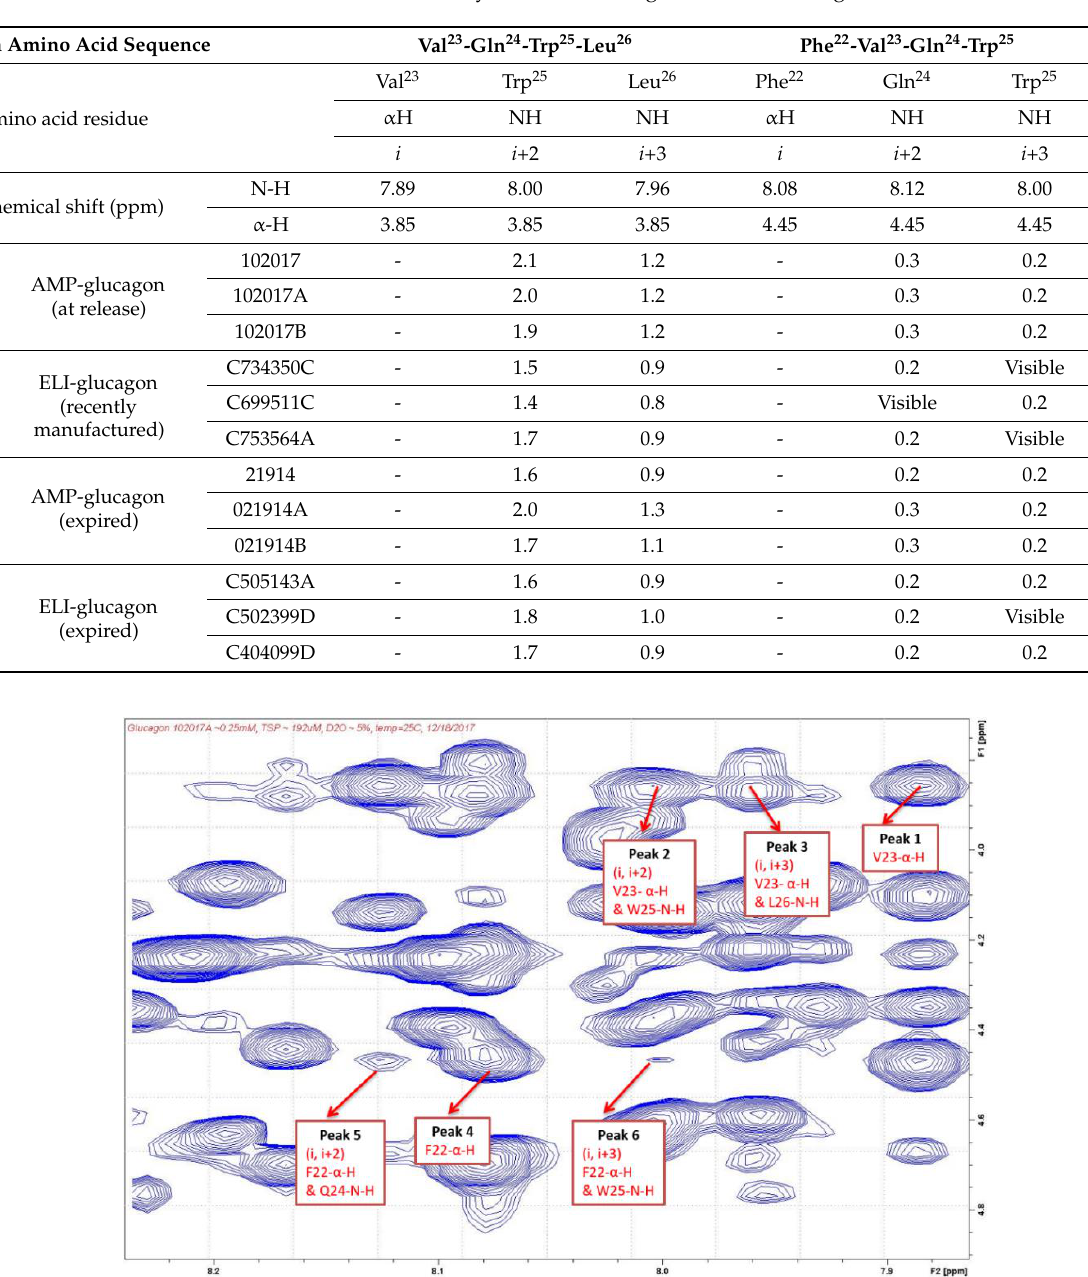
Figure 4. NOESY cross-peaks in ELI-glucagon. The complete chemical shift assignments of ELI-glucagon and AMP-glucagon are provided in Tables S1 and S2, respectively. For both glucagon products, the majority of the glucagon residues were assigned in the fingerprint region, with a few residues ambig- uously assigned due to overlapping peaks and weak peaks such as the α -H of Lys 12 . The observed chemical shifts were then compared with the respective reference values based on the chemical shift index. The H α chemical shifts of Phe 22 to Leu 26 for both ELI-glucagon (Table S3 and Figure S1) and AMP-glucagon (Table S4) were shown to be less than the CSI reference values (≤0.1 ppm or CSI of − 1), which indicates an α -helix between Phe 22 and Leu 26 . It was noted that several residues such as Ser 11 and Met 27 had possible alpha helix regions with CSI index values of −1. These residues were further analyzed for dαN con- nectivity, however, these residues did not have dαN( i , i +2) and/or dαN( i , i +3) interactions, indicating that there was no alpha helix. The dαN connec tivities were further confirmed by dNN connectivity studies which show Phe 22 and Leu 26 amide proton connectivities